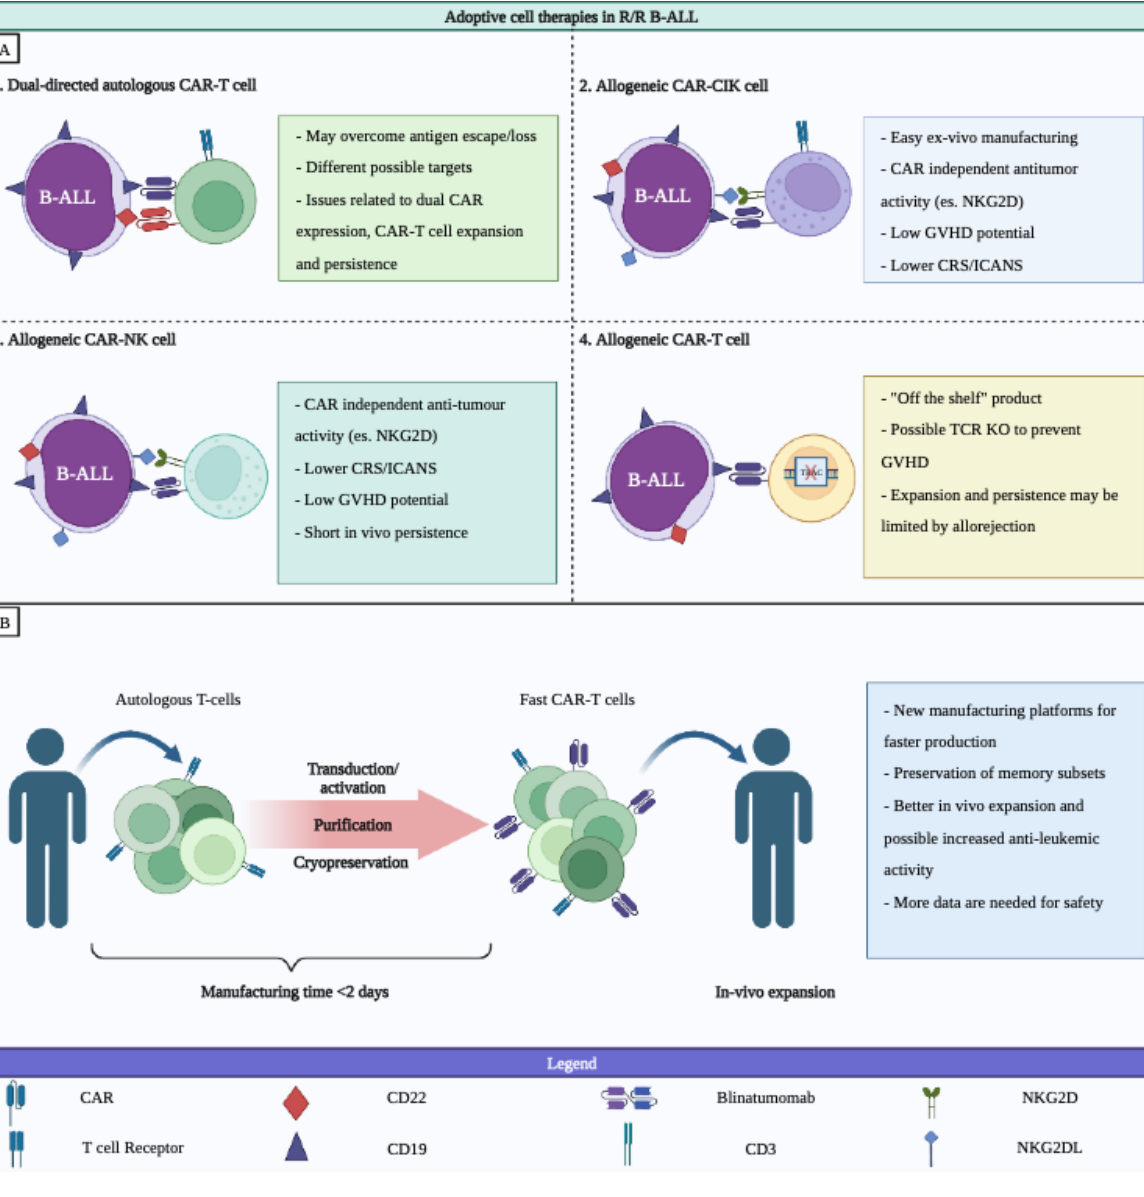
Figure 1. Novel approaches for exploration of immunotherapies in relapse/refractory BCP-ALL. Panel ( A ) new approaches with different adoptive cell therapies in relapse/refractory BCP-ALL Panel ( B ) key characteristics of the new manufacturing platforms for the fast production of CAR-T cells.